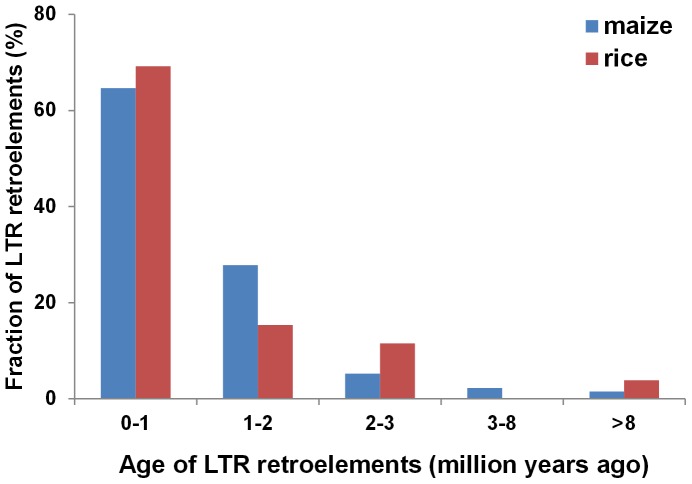
Ages of intact LTR retroelements in the candidate coding-MULEs in maize and rice.